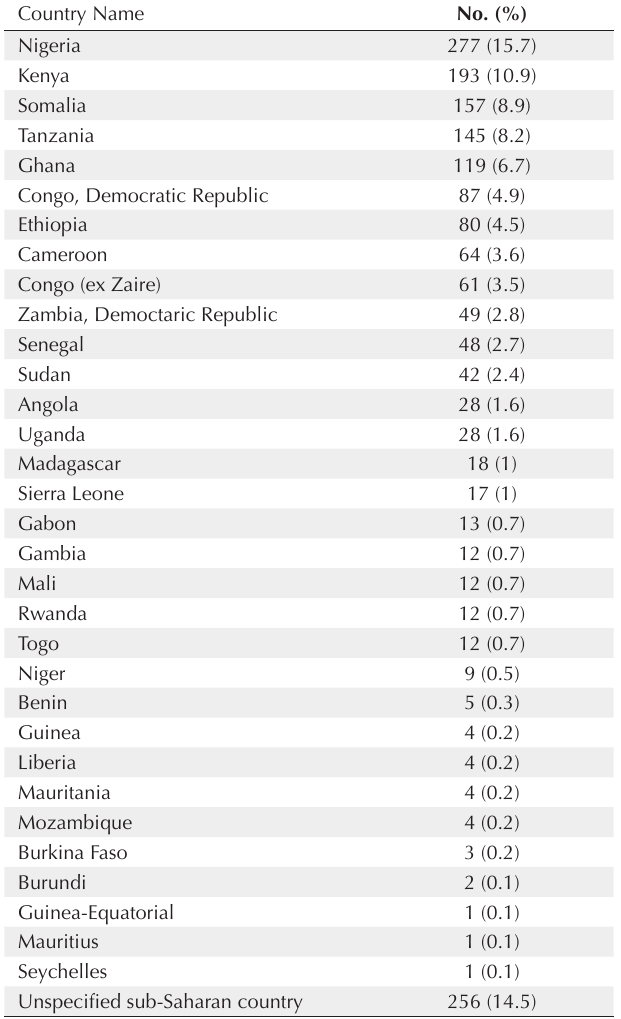
Table 3. Vaccination Rates Among 1768 International Travellers From Greece to Sub-Saharan Africa, 2011-2014